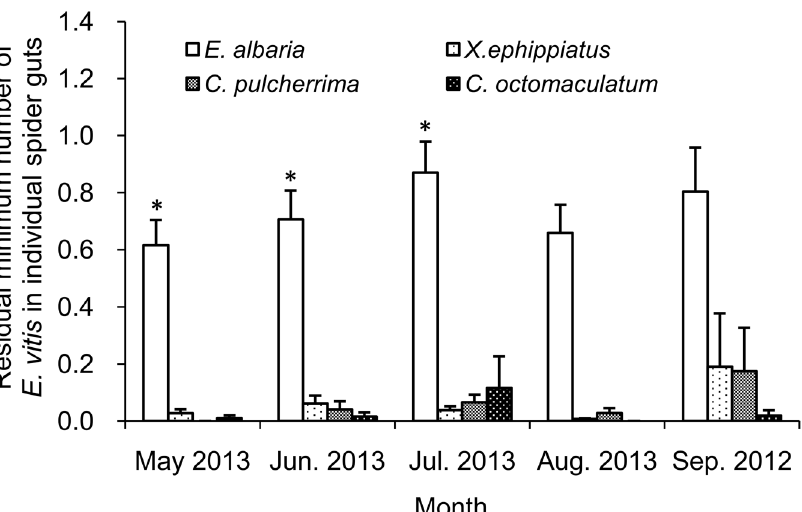
Figure 4. The residual minimum number of E . vitis in individual spider gut during the months when E . vitis was